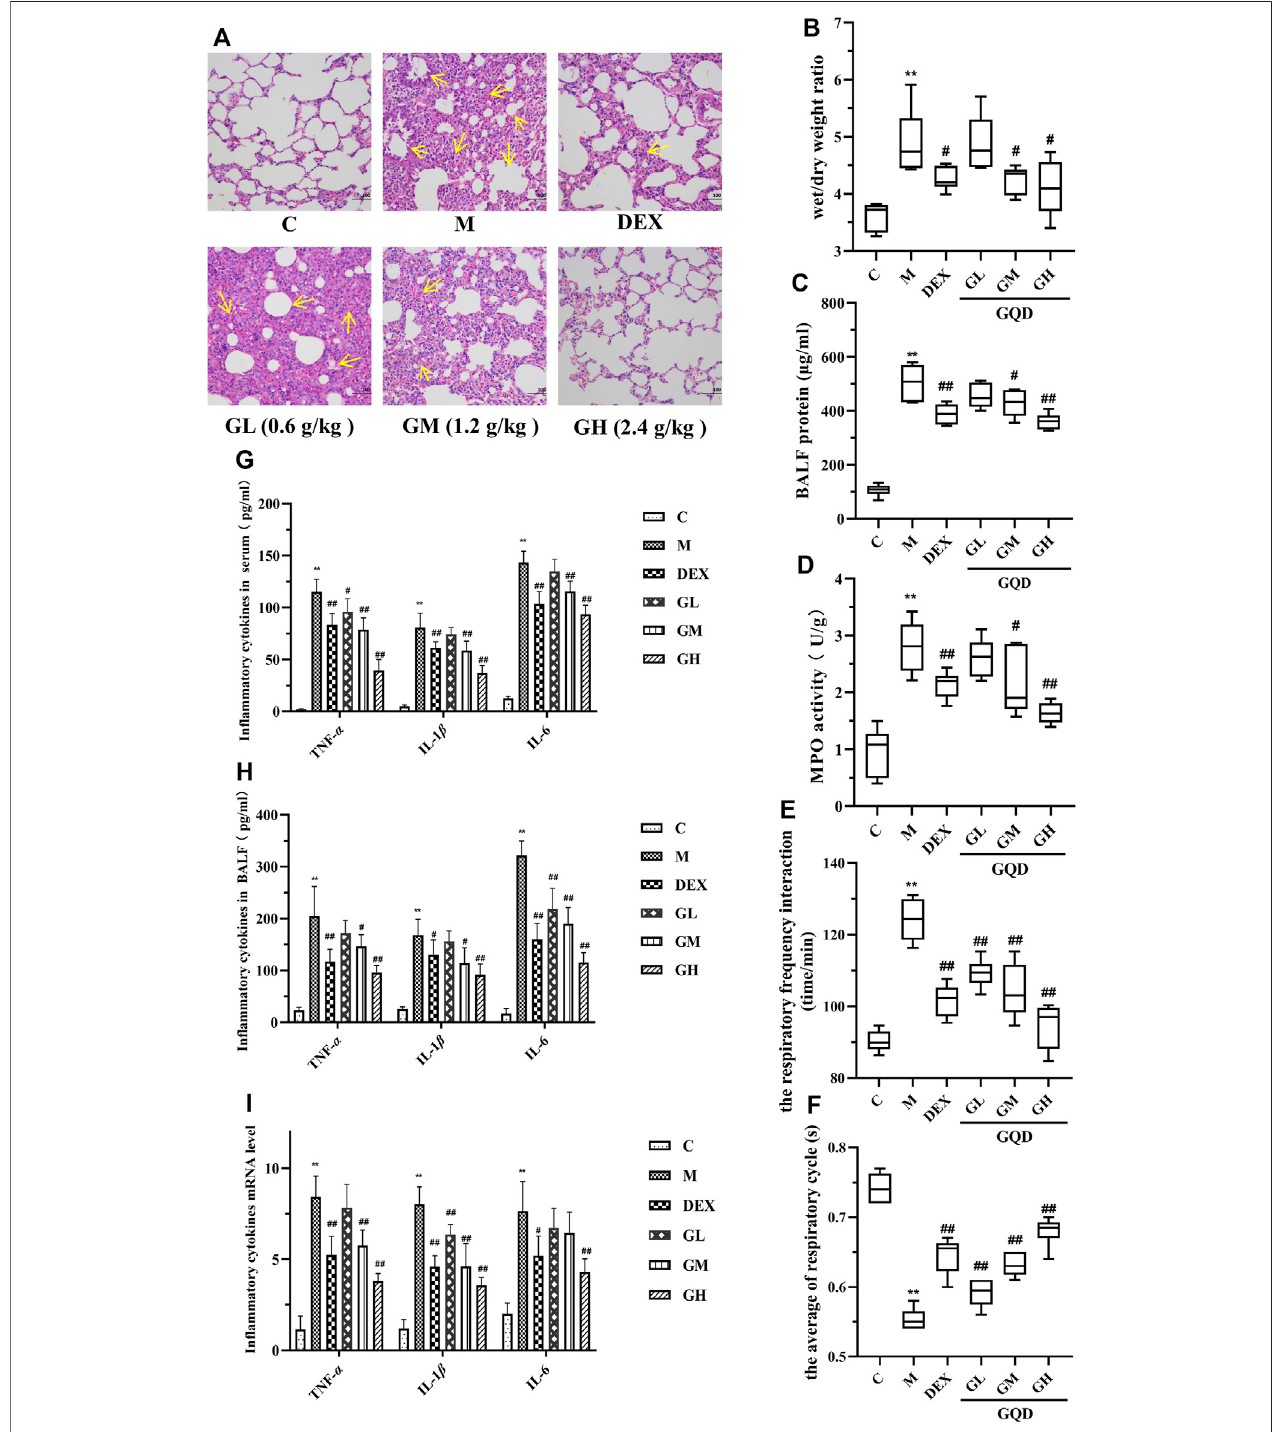
FIGURE 1 | GQD has protective effect on ALI induced by LPS in vivo ( n = 8). (A) Lung tissue sections were stained with hematoxylin and eosin (H,E) for histopathology analysis (magni fi cation ×200). (B) Lung wet/dry weight ratio. (C) Total protein contentin BALF. (D) MPO activity oflung tissue. (E) Changes inrespiratory frequency. (F) Changesinrespiratorycycle. (G) Cytokineactivityinserum. (H) Cytokine activityinBALF. (I) Expressionofcytokine mRNAinlungtissue.Thevaluesinthe fi gure were expressed as mean ± standard deviation. Compared with the control group, ** p < 0.01. Compare with model group, # p < 0.05, ## p < 0.01.